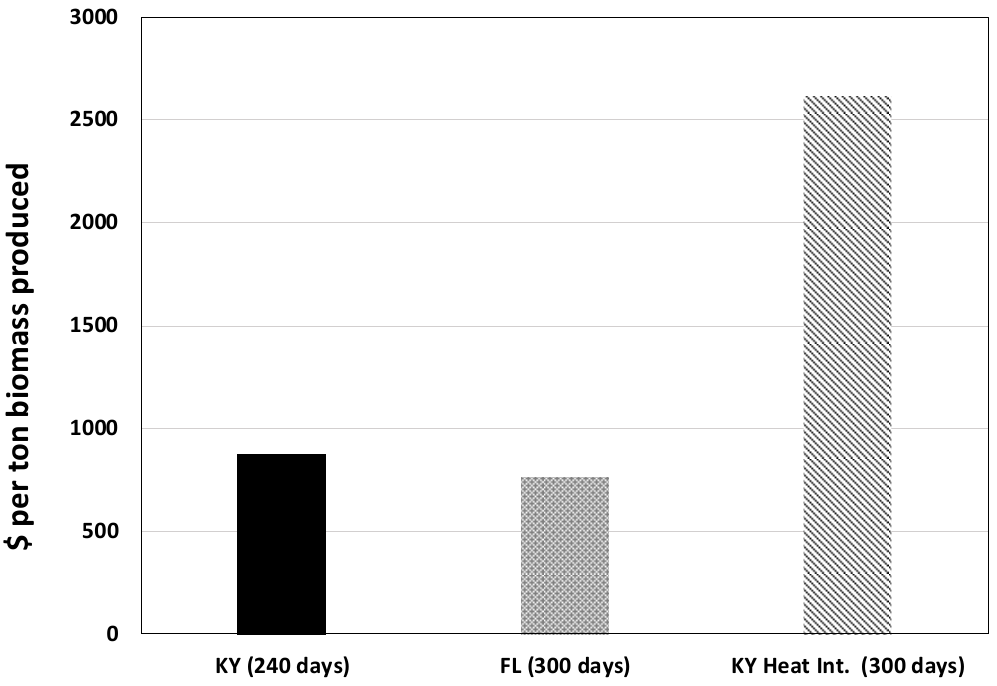
Figure 13. Cost of biomass production in $ ton − 1 for three separate PBRs, each at a 1 MW power plant. The first case corresponds to Kentucky, the second to Florida, and the third to the same PBR in Kentucky with heat integration. Numbers include capital and operating cost over a 30 year amortization period assuming a baseline biomass production cost of $875 tonne − 1 . The cost of capital is not included.